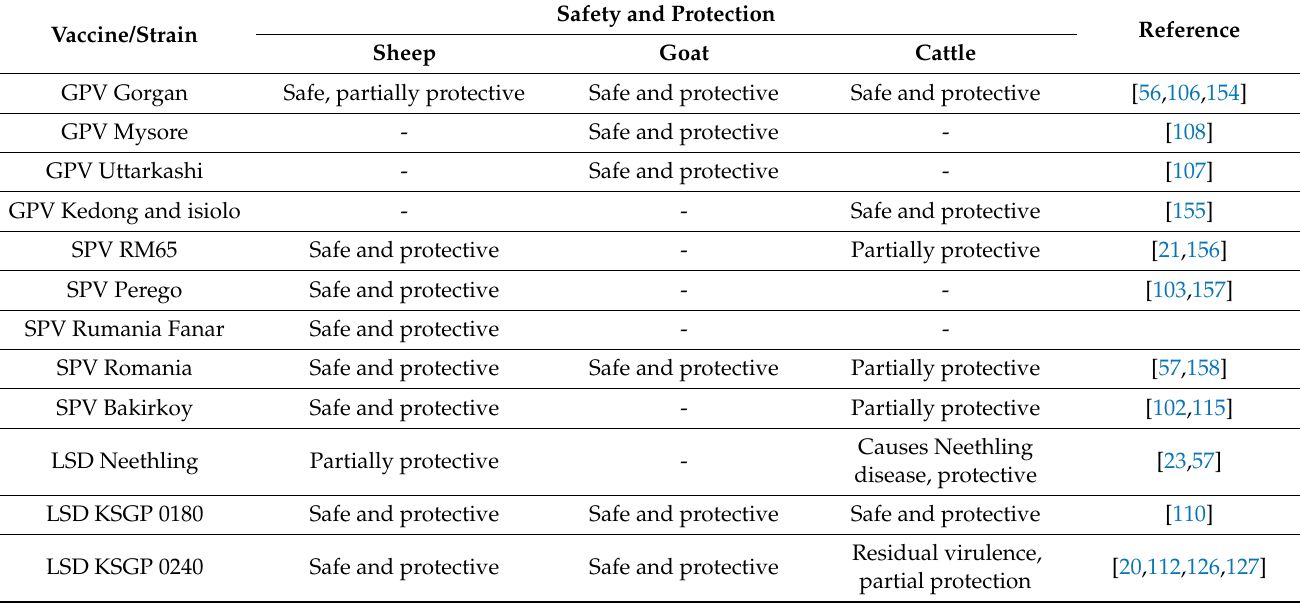
Table 2. Conferred protection by capripoxvirus